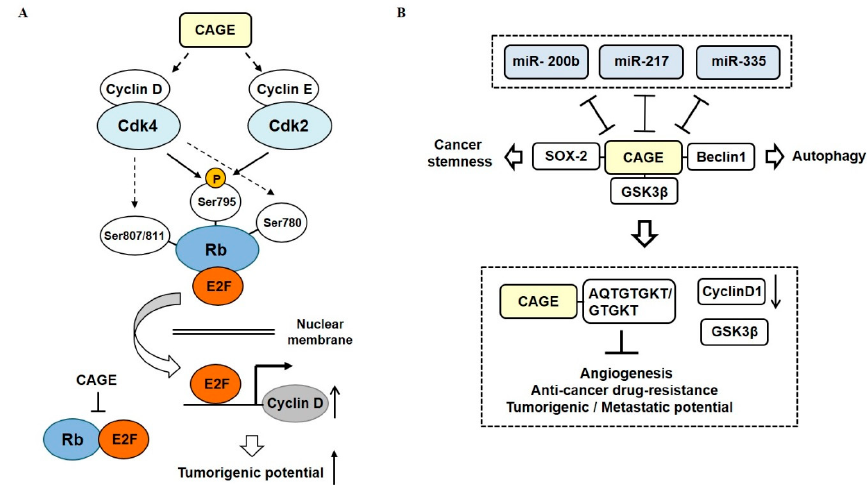
Figure 6. CAGE-miRNA network in anti-cancer drug resistance. ( A ) CAGE increases expression levels of cyclins, which in turn increases cyclin-dependent kinase (CDK) activities. Increased CDK activities phosphorylate Rb to inactivate the Rb protein. Inactivation of Rb leads to the activation of E2 factor (E2F). Activated E2F binds to promoter sequences of cyclins. ( B ) MiR-200b, miR-217, and miR-335 form negative feedback loops with CAGE. CAGE binds to GSK3 β , which increases expression of cyclin D1 to confer resistance to anti-cancer drugs. AQTGTGKT, as a CAGE-derived peptide can disrupt the interaction between CAGE and GSK3 β and confer sensitivity to anti-cancer drugs. The T-bar arrows denote negative regulation and both side T-bar arrows denote cross inhibition. The hollow arrows denote positive